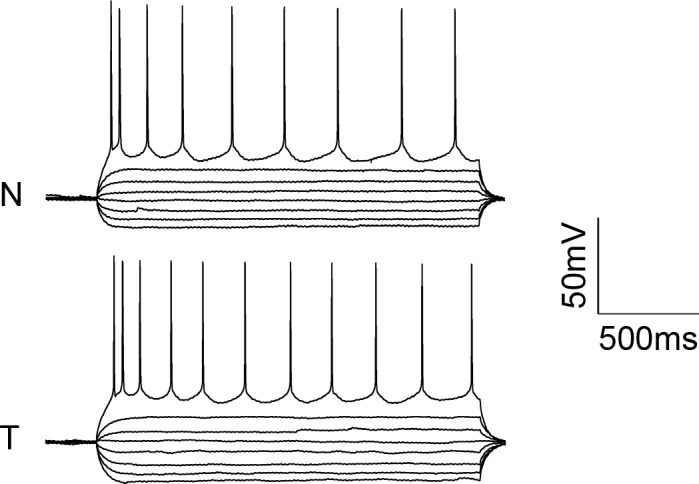
Action potentials triggered in neurons expressing nontargeted (N) or targeted (T) ChR2 in response to stepwise current injections ranging from −100 to 110 pA in 30 pA steps.